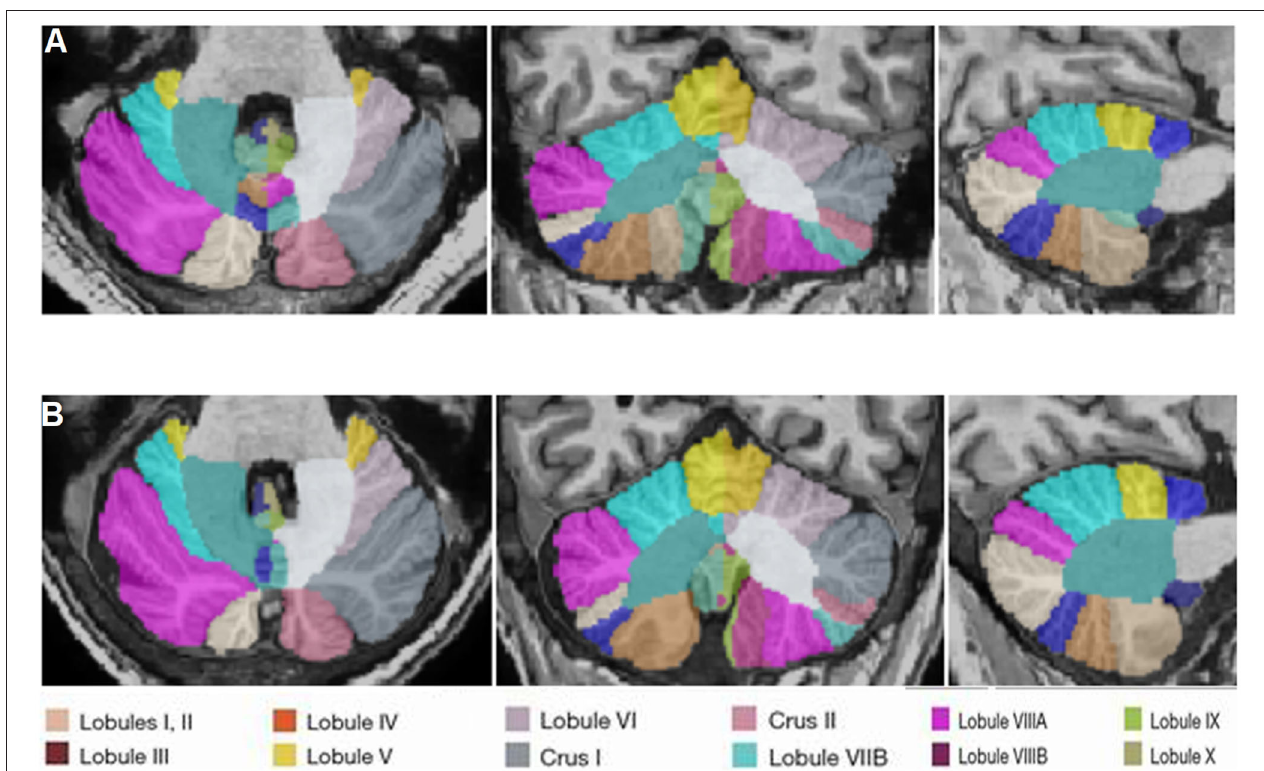
FIGURE 2 | Representative CERES images of cerebellum and lobules taken from a healthy control (male, 44 years old) (A) and a patient with gluten ataxia (male, 55 years old) (B)